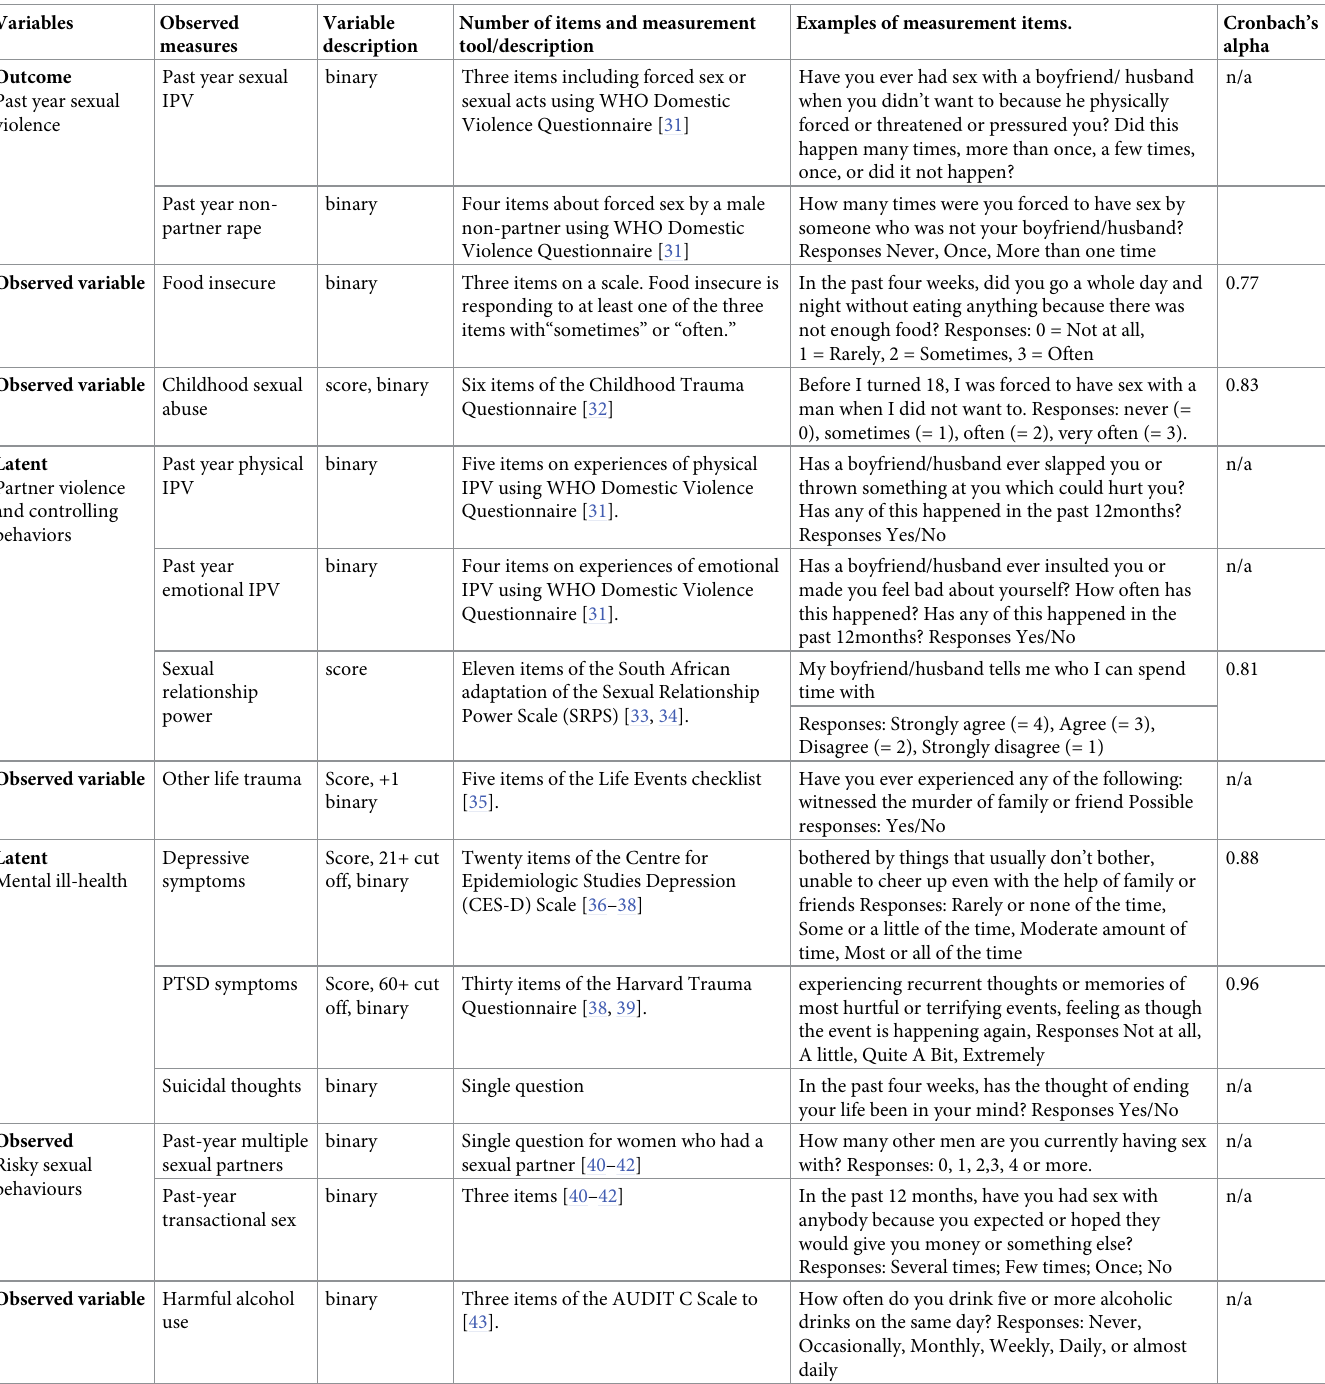
Table 1. Definitions and measurement of variables. Female students survey: South African Technical Vocational Education and Training (TVET) colleges and universi- ties (2018–2019).